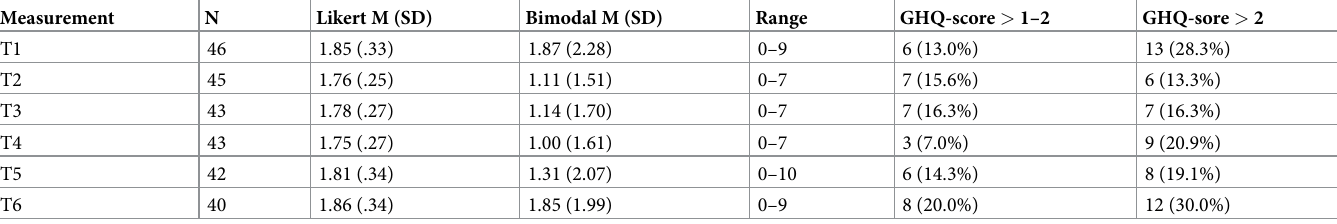
Table 3. Perceived psychological distress across time